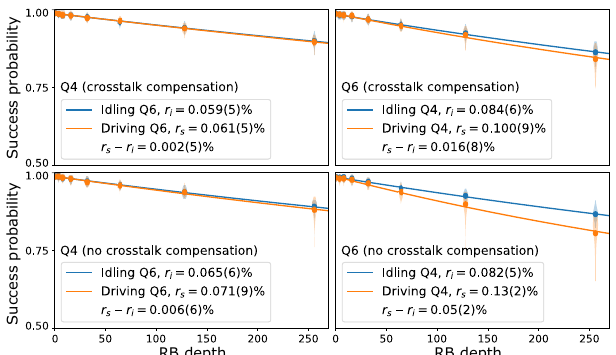
FIG. 2. Simultaneous DRB on the AQT platform. We run simultaneous DRB experiments (details in the main text) on the AQT device’s Q4–Q6 subsystem both with (top) and with- out (bottom) crosstalk compensation enabled. Estimates of each qubit’s average error-per-gate are extracted in two contexts: “idling spectator” ( r i ) and “driving spectator” ( r s ). The increase in each qubit’s r due to driving the spectator is a high-level mea- sure of crosstalk-induced errors on that qubit. Uncertainties are 95% confidence intervals obtained from bootstrapping. Violin plot regions around each point indicate the distribution of the 30 individual DRB circuits whose average success probability is represented by the point. There is no statistically significant evidence of crosstalk-induced errors from Q6 → Q4. However, there is significant evidence of crosstalk from Q4 → Q6, and it is reduced (though not eliminated) by crosstalk